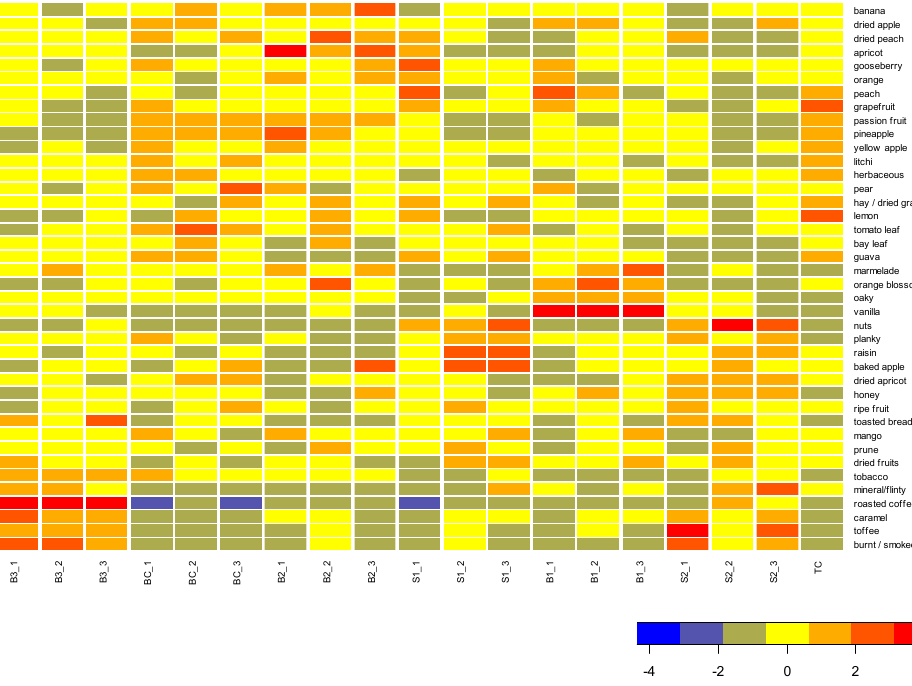
Figure A2. Heat maps constructed based on the standardized residuals that were generated by the correspondence analyses of individual repeats obtained with the trained panel ( n = 20) after 4 months of oak maturation. The more negative (i.e., the more “blue” on the heatmap) the residuals, the more indication that the correspondence (co-occurrence) between the items are less than what would be expected under the assumption of complete random occurrence. And vice versa, the more positive (i.e., the more red on the heatmap) the residuals, the more indication that the co-occurrence are more that expected under complete random occurrence. TC: Tank control, BC: Barrel control, B: New barrel treatments, S: Stave